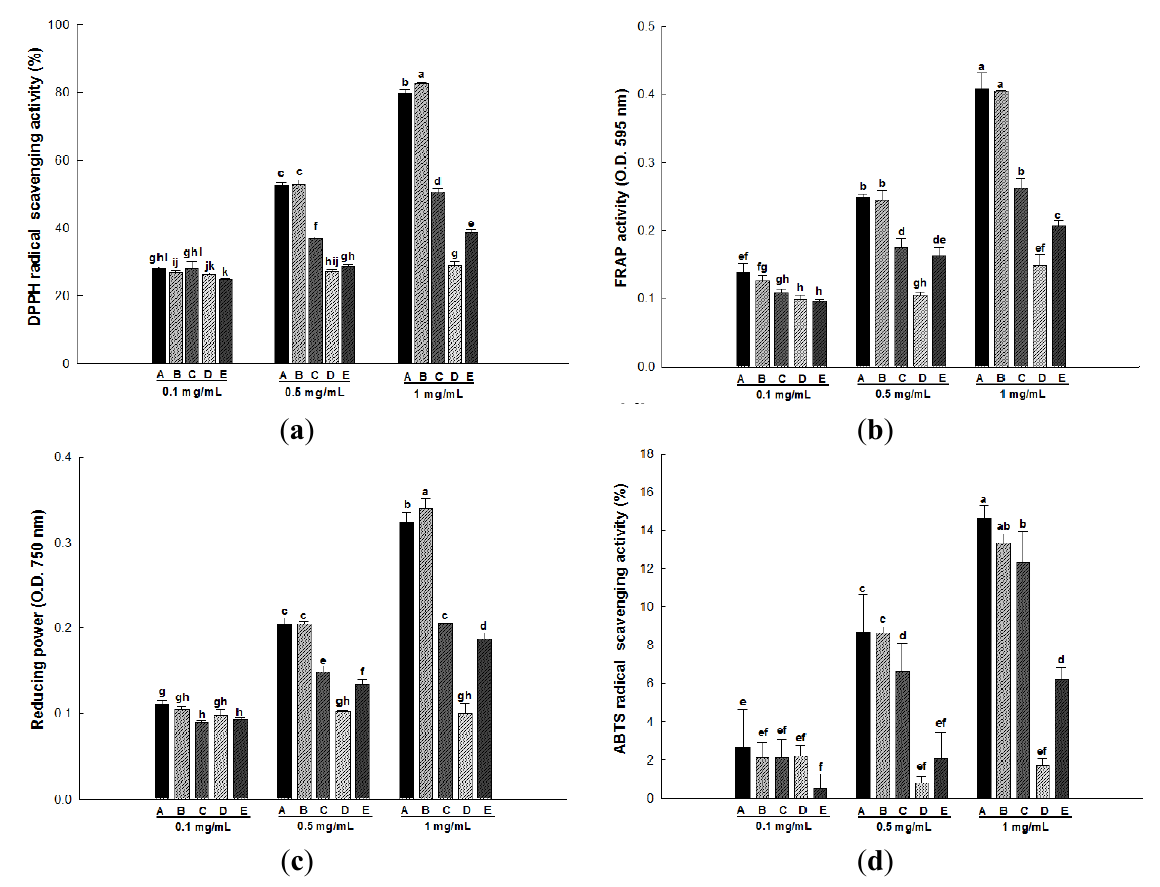
Figure 1. DPPH radical scavenging activity ( a ), FRAP activity ( b ), reducing power ( c ) and ABTS radical scavenging activity ( d ) of five wild herb extracts at various concentrations. A, Aster scaber ; B, Ligularia fischeri ; C, Kalopanax pictus ; D, Codonopsis lanceolata ; E, Cirsium setidens . All values are presented as the means ± SD. Bars with different letters indicate statistically significant differences among groups at p < 0.05 by one-way